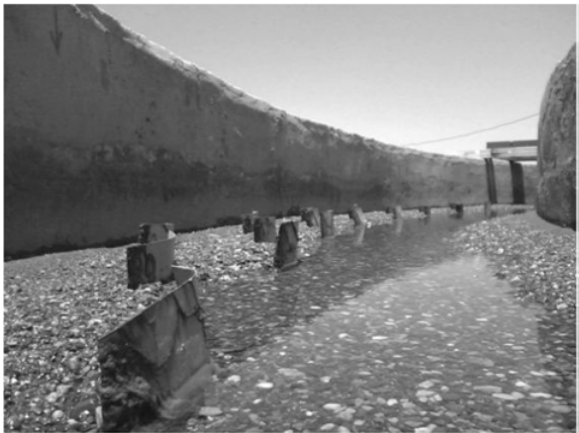
Fig. 5 . Plan view of curved-vanes installation on the bed of model with 3-vanes in a row at zigzag patterns.